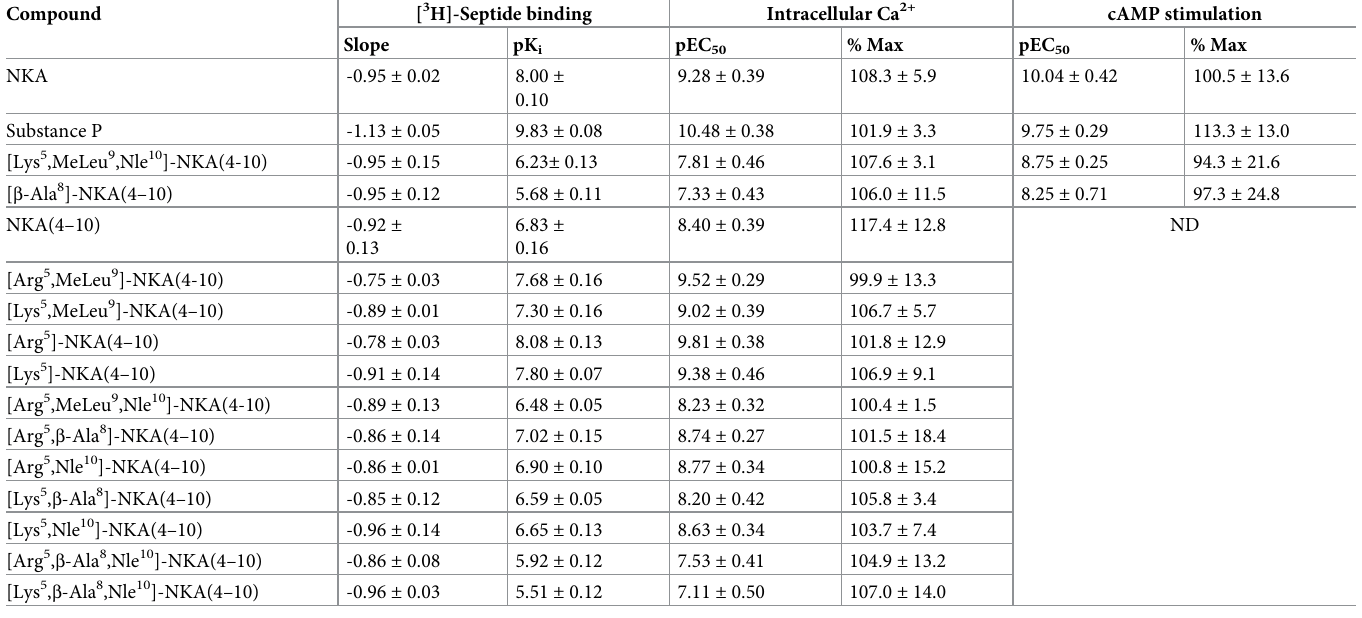
Table 3. Displacement of [ 3 H]-Septide binding, intracellular calcium response and stimulation of cyclic AMP in CHO cells expressing human recombinant NK1 receptors. Compound